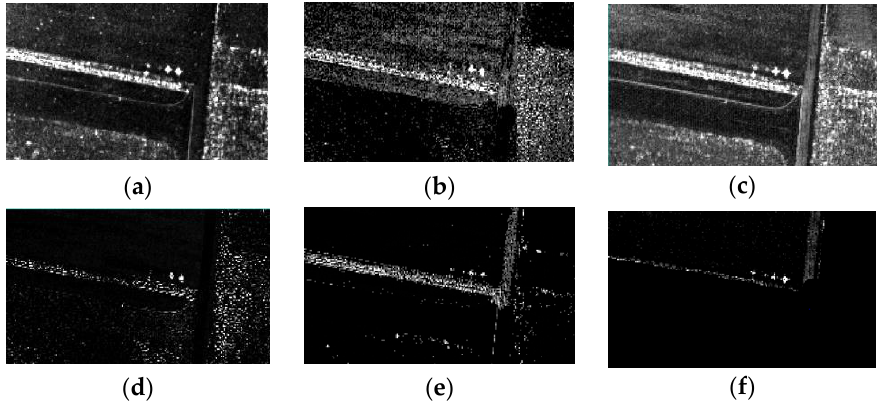
Figure 8. The target detection results of the different methods on the metal plates data set. ( a ) Reed—Xiaoli detector (RXD); ( b ) the segmented RX detector (SegRX); ( c ) the low-rank and sparse representation-based detector (LRASR); ( d ) the low-rank and sparse matrix decomposition (LRaSMD)-based Mahalanobis distance method (LSMAD); ( e ) the locally enhanced low-rank prior method (LELRP-AD); and ( f ) anomaly detection method combining emissivity and a segmented low-rank prior (EaSLRP).